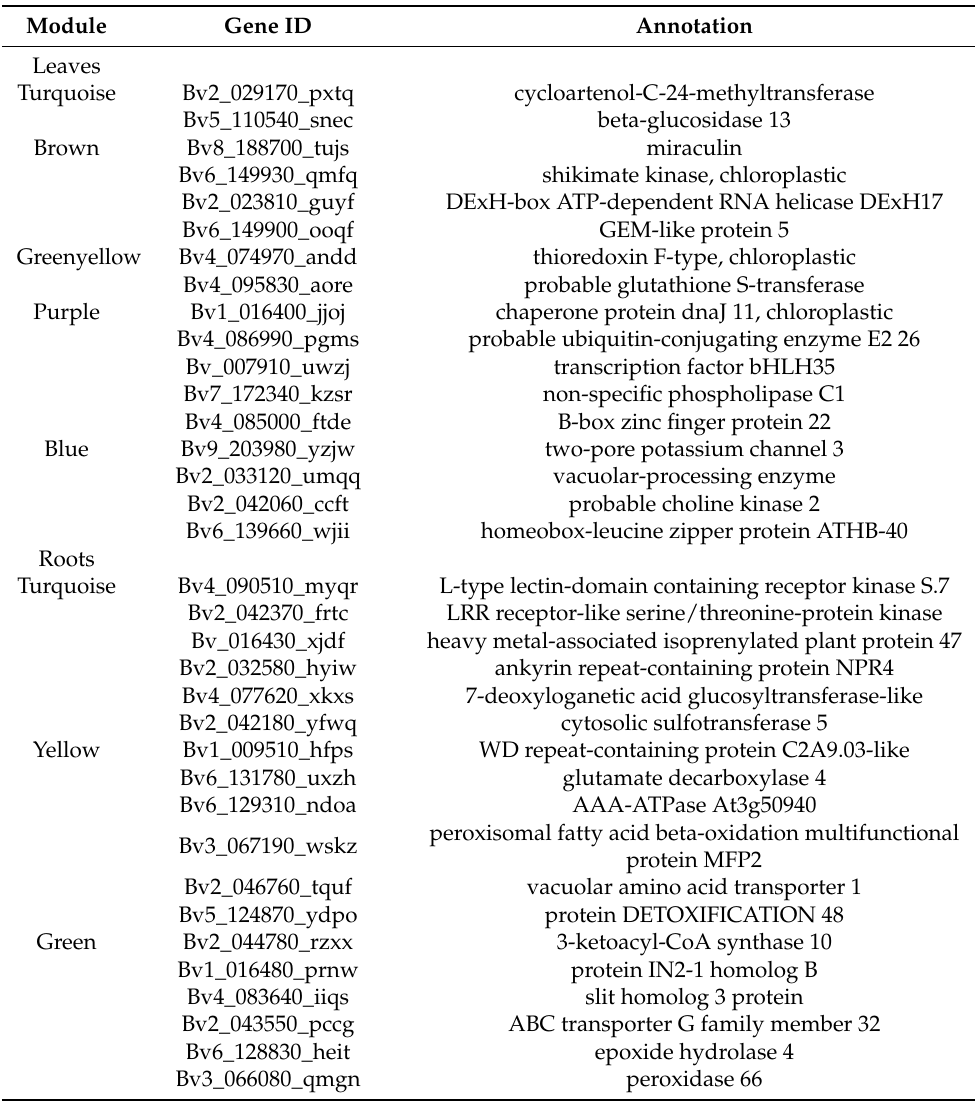
Table 1. The hub genes detected in WGCNA modules in leaves and